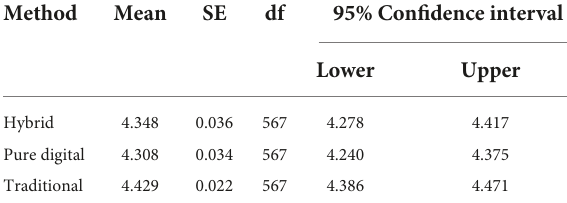
TABLE 10 Estimated marginal means comparison.